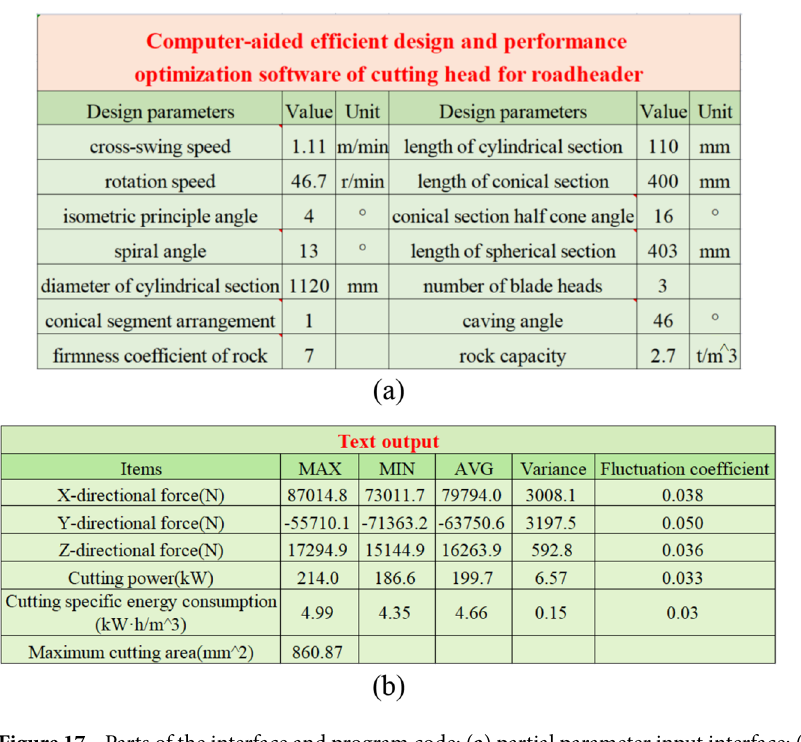
Figure 17. Parts of the interface and program code: ( a ) partial parameter input interface; ( b ) partial text output interface.